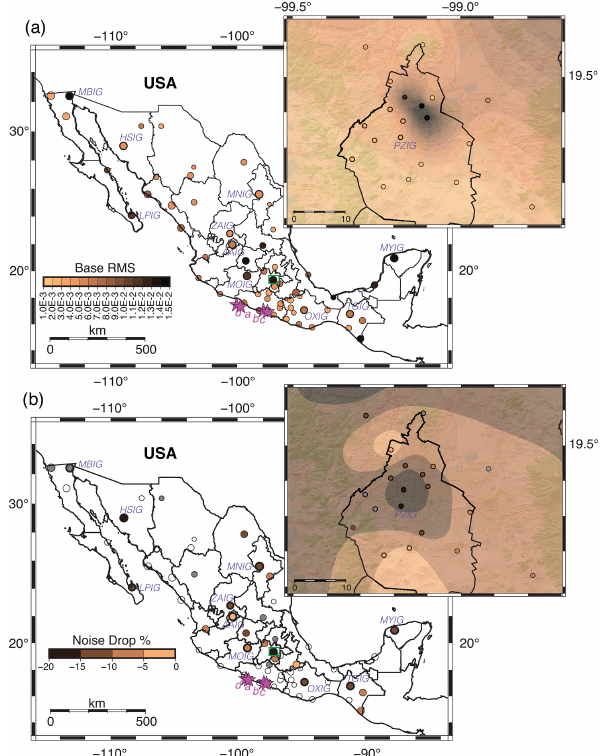
Figure 1. (a) Noise rms level and (b) drop at seismic stations in Mexico. The pink stars indicate the location of the (a) 2020 M 5.0, (b) 2019 M 4.9, (c) 2017 M 4.9, and (d) 2016 M 5.0 earthquakes. The green box corresponds to the Valley of Mexico, shown in the inset. Symbol size is proportional to the municipality population (CEDRUS, 2019) where the station is located.